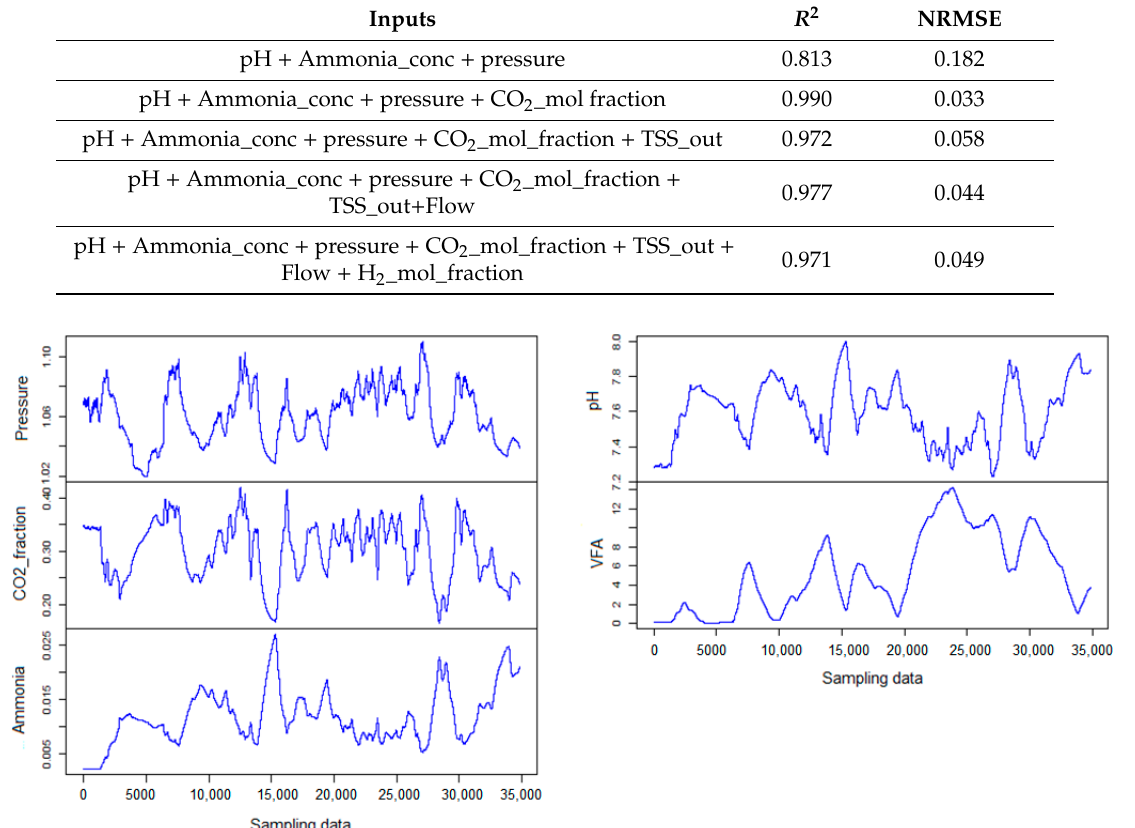
Table 5. Result of di ff erent subsets trained by support vector machine (SVM).